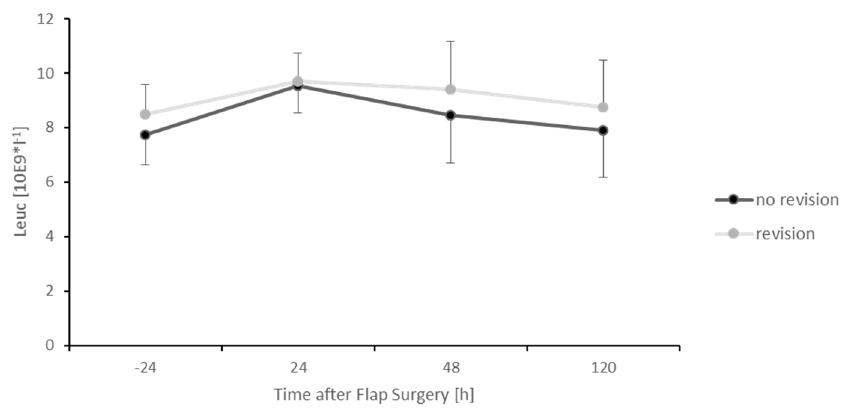
Figure 5. Postoperative CRP levels divided into two groups. Subjects that needed surgical revision due to thrombosis of the microanastomosis (grey) and subjects without surgical revision (black). Error bars refer to the corresponding standard deviations (* p ≤ 0.05).